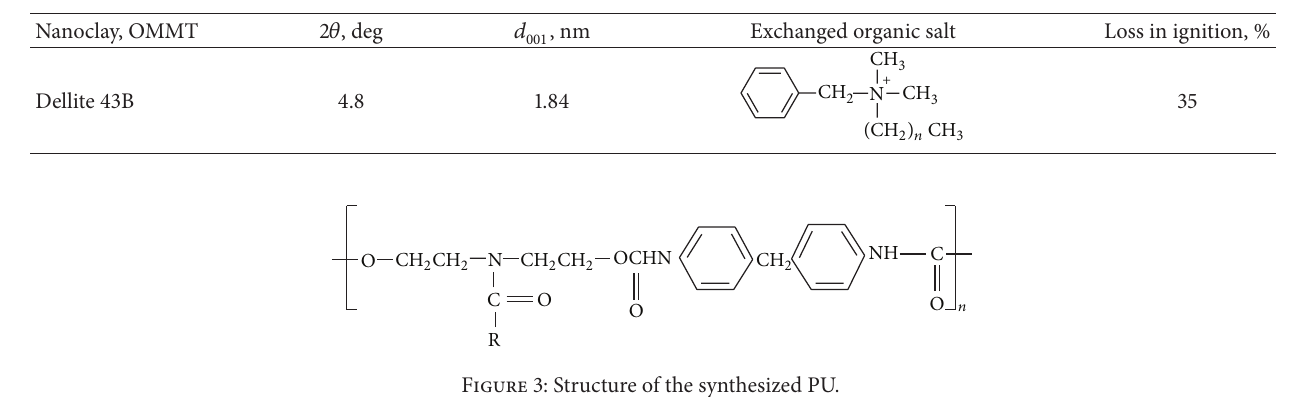
Table 1: OMMT characteristics.